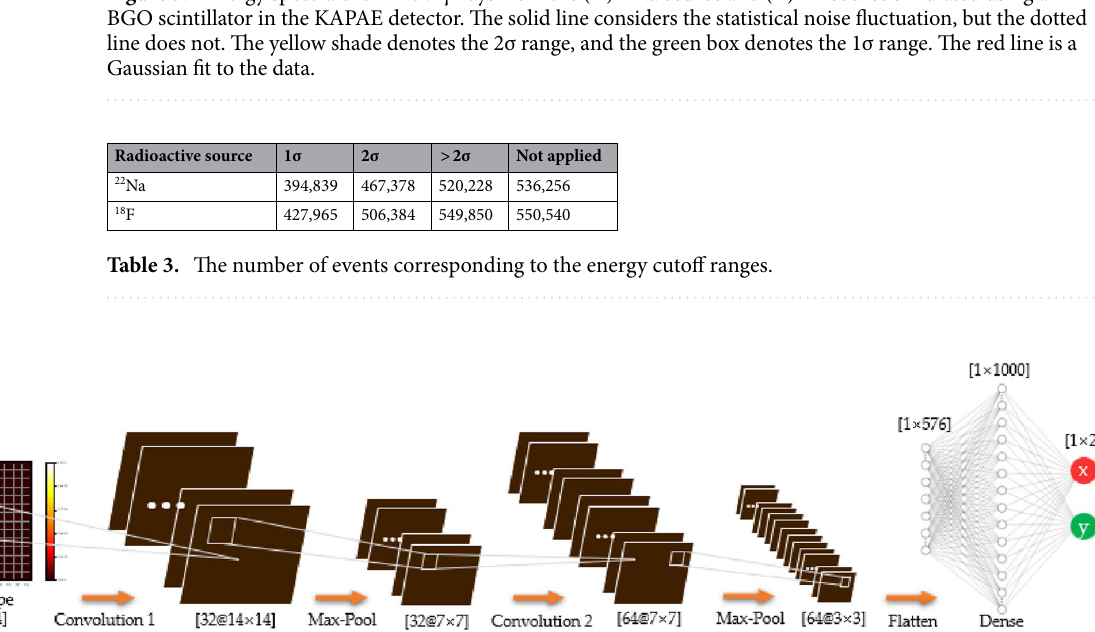
Figure 6. The proposed CNN architecture for Ps annihilation localization in the KAPAE